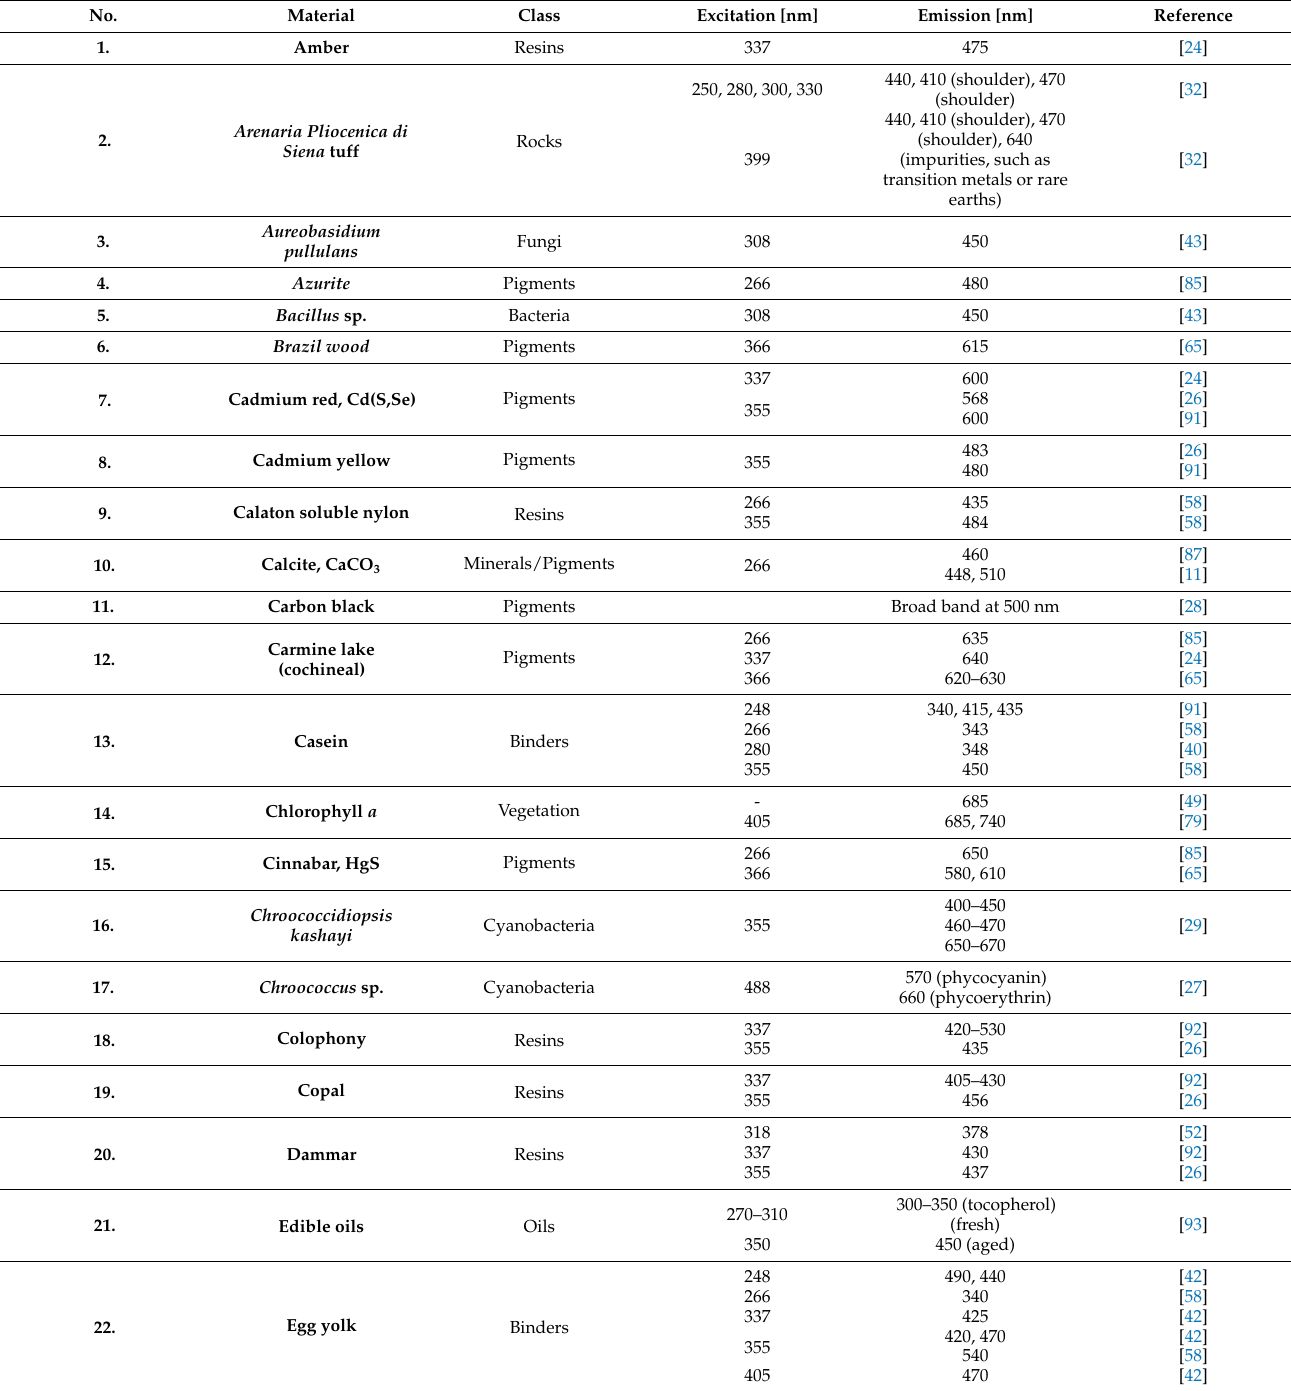
Table 1. Synthesis of excitation and emission wavelengths of the main fluorophores encountered in the